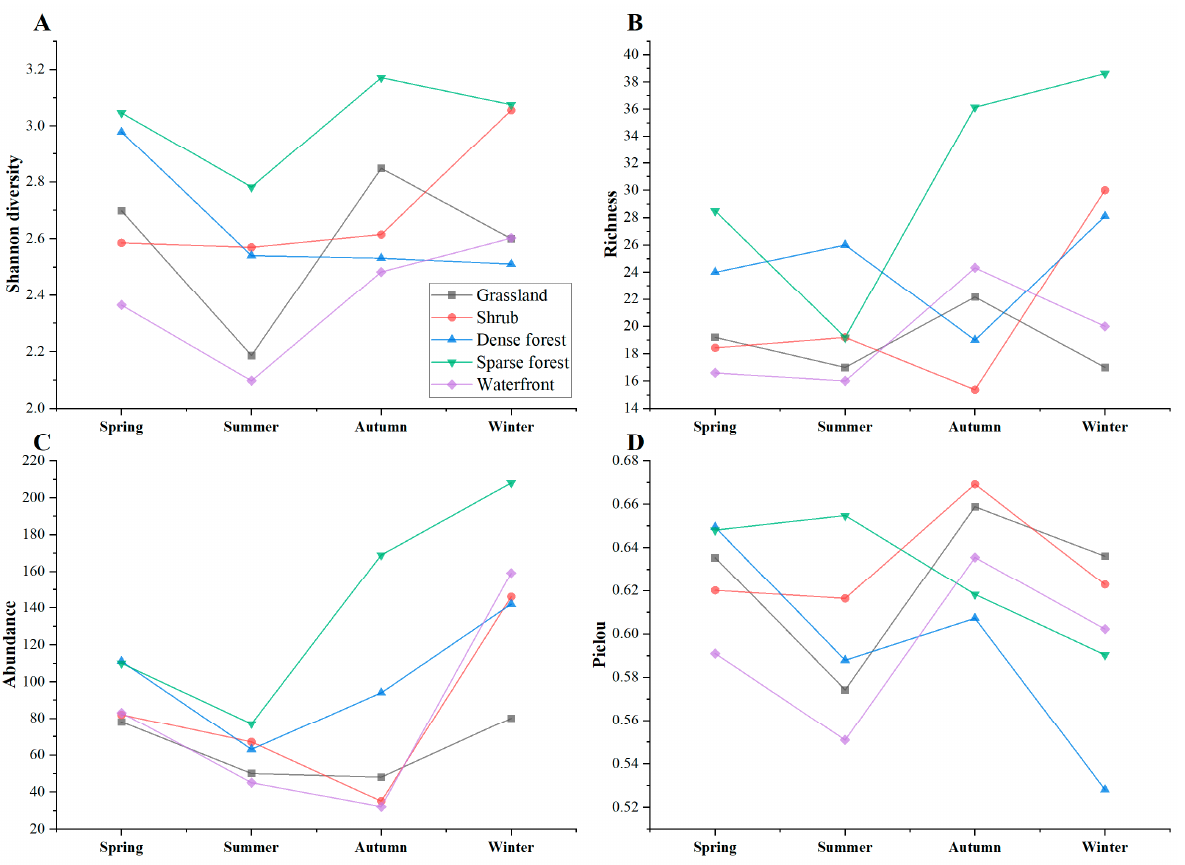
Figure 8. Comparison of bird diversity ( A ), richness ( B ), abundance ( C ), and Pielou index ( D ) with seasonal variation in five habitats in urban mountain parks in Fuzhou, China. Table 1. Principal component analysis was performed on the variables (predictor variables) of different vegetation habitats in urban mountain